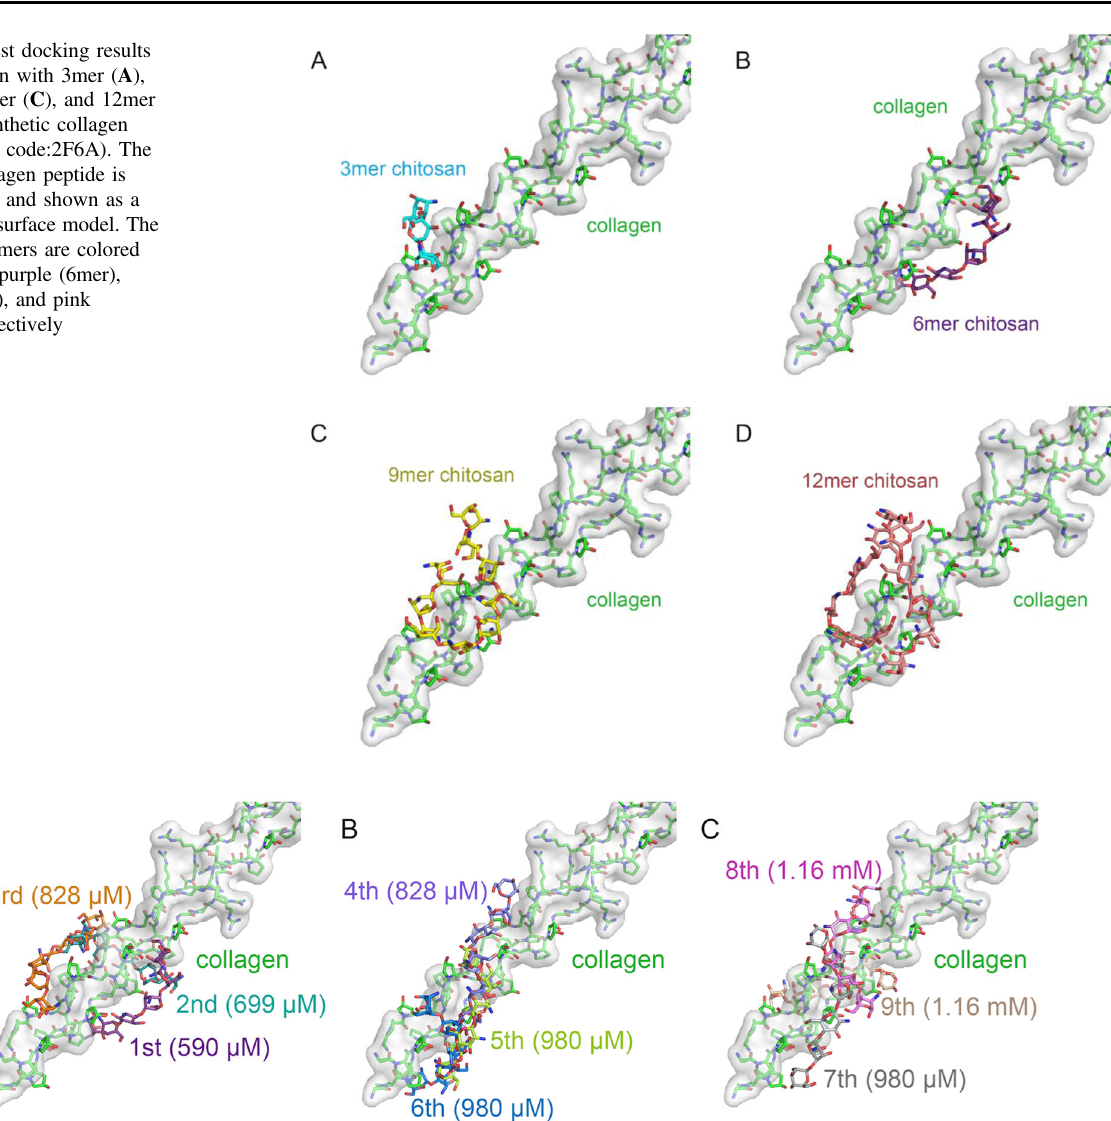
Fig. 3 The best nine docking results of 6mer chitosan to the synthetic collagen peptide (PDB code:2F6A) with slightly different af fi nity, nominating in descending order of the predictive binding af fi nity